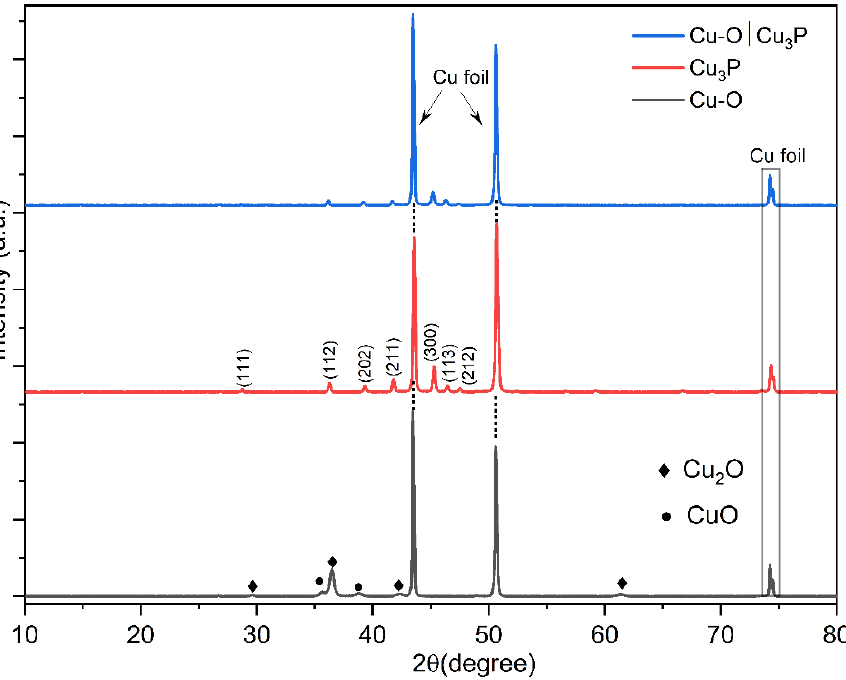
Figure 1. The powder XRD of Cu-O, Cu 3 P, and Cu 3 P|Cu-O. X-ray photoelectron spectroscopy (XPS) analysis was used to examine the formed hybrid nanostructure’s chemical states and surface nature (Table S1). Figure 2a stands for the 2p high-resolution XP spectrum of Cu 2p. The peaks located at the binding energy positions of 933.1 eV belong to Cu 2p 3/2 of Cu(I), which could be due to the